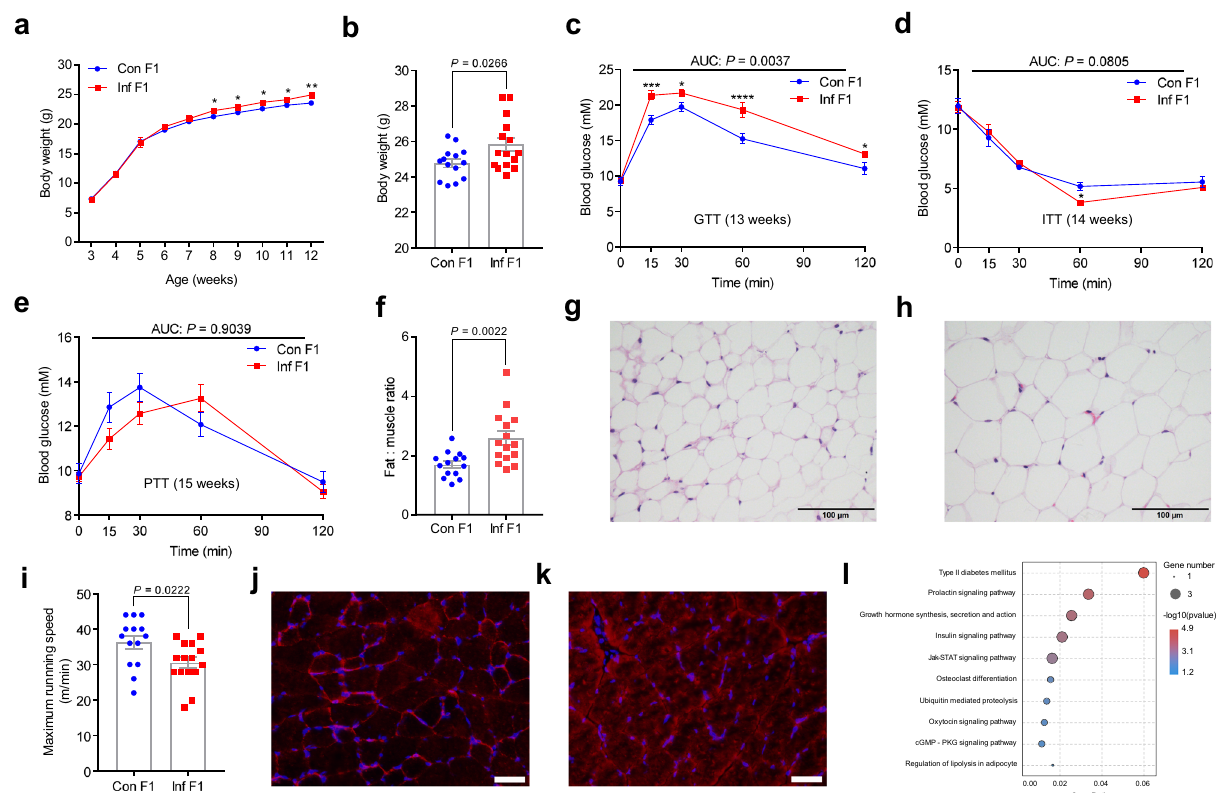
Fig. 1 Body weight and metabolic parameters of F1 males with paternal in fl ammation. Male mice were treated with LPS (Inf) or saline (Con) once every other day for a total of four injections in 7 days to establish an in fl ammatory model. These mice were then allowed to mate with normal females for two days. a Growth curves for F1 male offspring from Con- and Inf- fathers. Statistical analysis was performed by a MIXED procedure for repeated measures. * P < 0.05; ** P < 0.01. b Body weight of male offspring at 15 weeks of age. c – e Blood glucose by GTT at 13 weeks ( c ), ITT at 14 weeks ( d ), and PTT at 15 weeks ( e ) of age. In ( c , d ) and ( e ), n = 7 mice per group. AUC, area under the curve. * P < 0.05; *** P < 0.001; **** P < 0.0001. f Ratio of fat-to-muscle weight of male offspring at 15 weeks of age. g , h Representative images showing adipocyte area in perigonadal fat of Con F1 ( g ) and Inf F1 ( h ) male mice. n = 5 mice per group. Scale bar = 100 μ m. i Treadmill test results of male offspring at 12 weeks of age. In ( b , f ) and ( i ), n = 14 in Con and n = 15 in Inf. Statistical analysis was performed by two-tailed unpaired Student ’ s t test ( b , f , i ), by two-tailed, two-way analysis of variance (ANOVA), uncorrected Fisher ’ s least signi fi cant difference (LSD) ( c – e ). Data are show as mean ± SEM. j , k Representative images showing cryosections of gastrocnemius muscle (cross sections) from Con F1 ( j ) and Inf F1 ( k ) mice stained with antibodies against GLUT4 (red) and DAPI (blue). n = 5 mice per group. Scale bar = 50 μ m. l The top ten signi fi cant clusters of gene ontology (KEGG) terms enriched in gastrocnemius muscle samples of Con F1 and Inf F1 male offspring determined by GSEA and clustered under parent terms were related to synaptic signaling ( n = 4, NES > | 1.5| and FDR < 0.05). Source data are provided as a Source Data fi